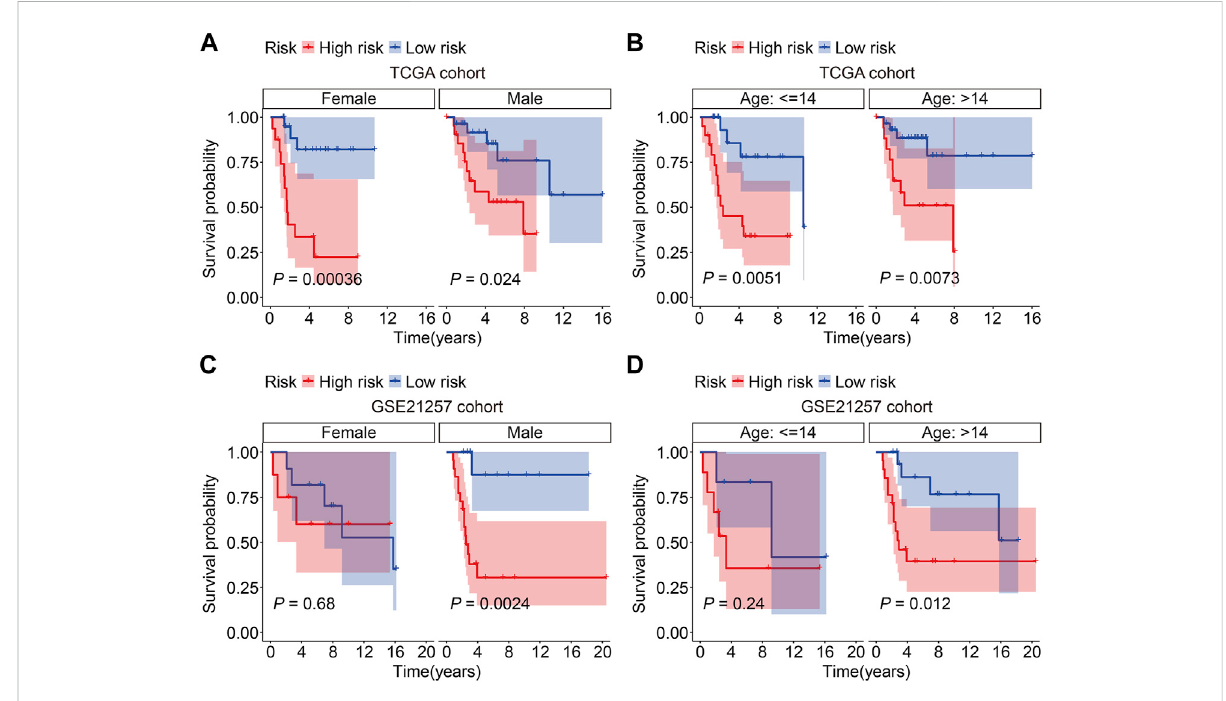
FIGURE 6 Kaplan – Meier survival curves in multiple subgroups strati fi ed by gender (A and C) or age (B and D) in both TCGA and GSE21257